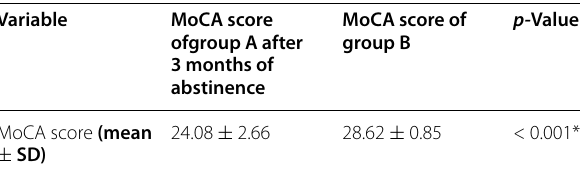
Table 5 Comparison of MoCA score in cannabis users after 3 months of abstinence with base line score of nonusers using